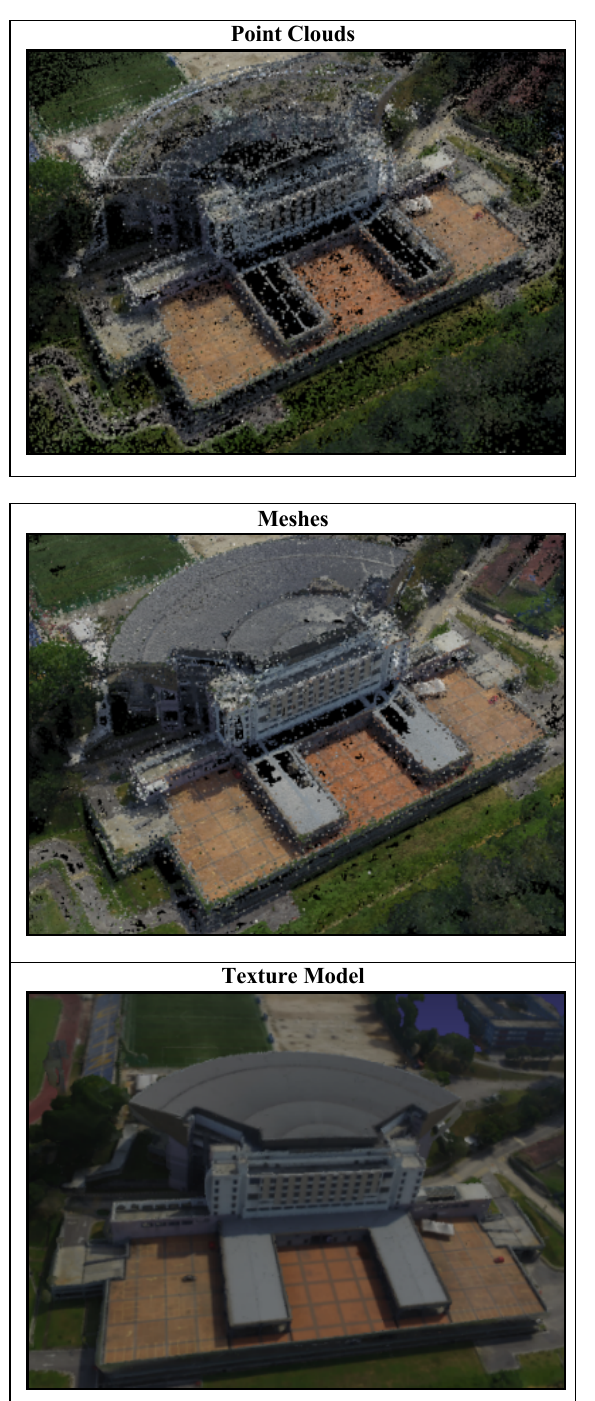
Figure 6. The visualisation of texture model of 3D